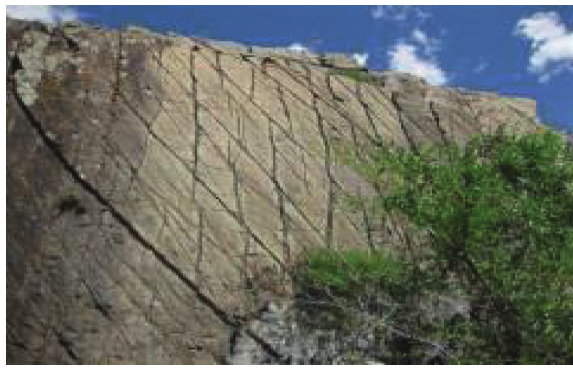
Figure 1: Cross fractures in rock